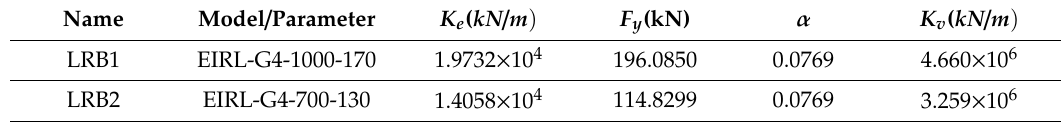
Table 2. LRB material properties (= 0.1, and = 0.9 based on equation (1)). Name Model/Parameter 𝐾 (cid:3032) ( 𝑘𝑁/𝑚)